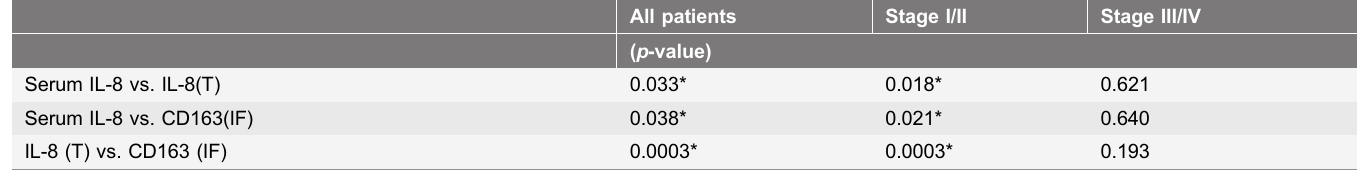
Table 3. Relationship between serum IL-8 and IL-8(T), between serum IL-8 and CD163(IF), between IL-8(T) and CD163(IF).